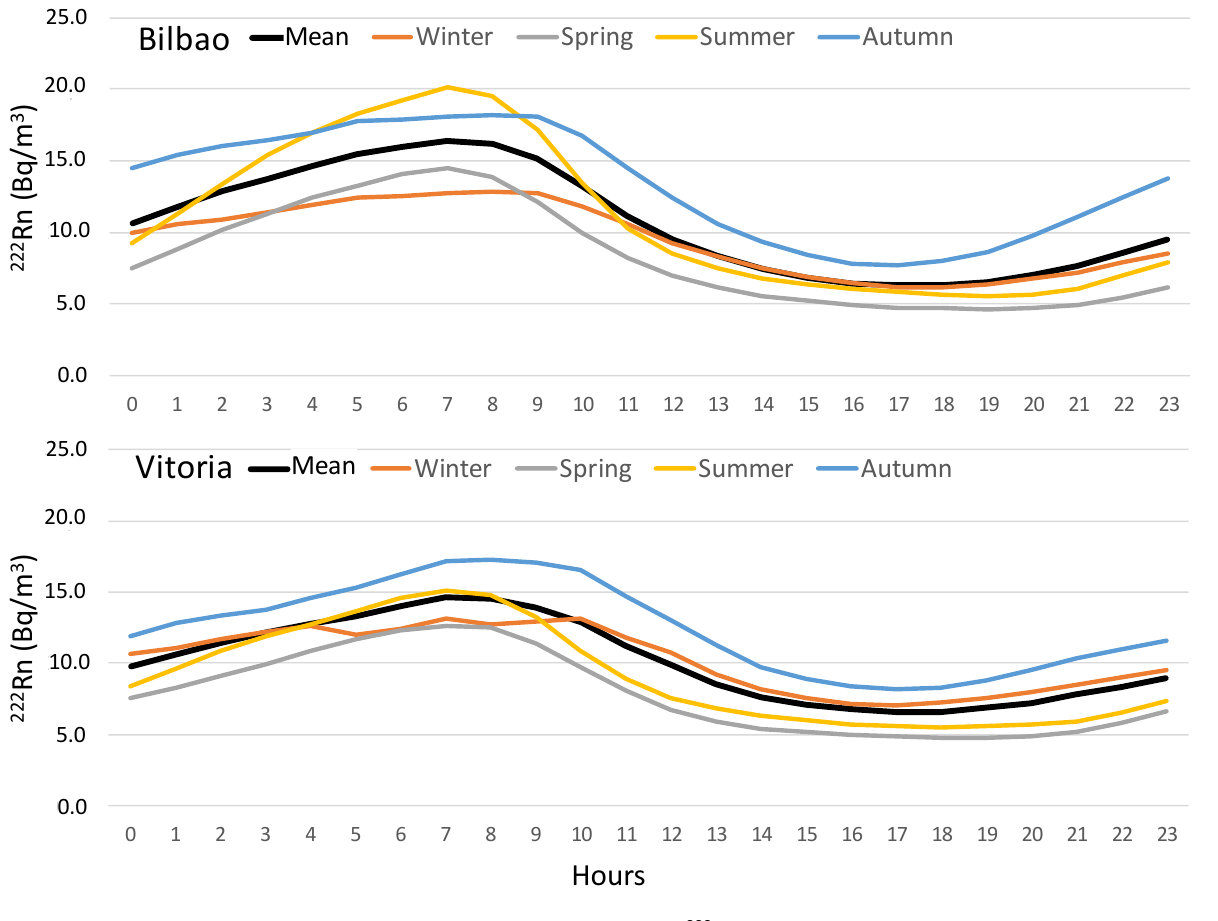
Figure 4. Total and seasonal daily average 222 Rn evolution for Bilbao and Vitoria during the sampling period (June 2012 – June 2015).